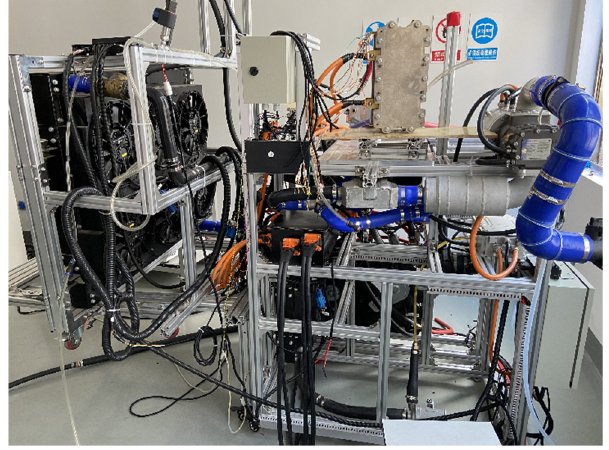
Figure 2. The test bench.